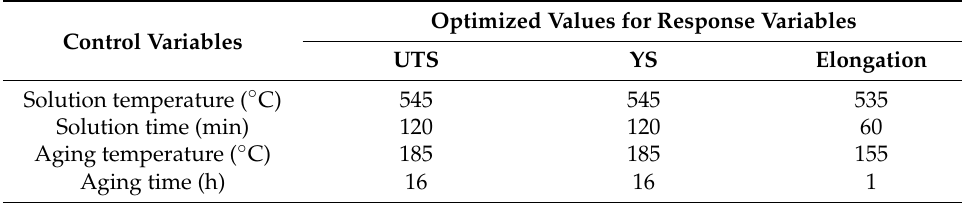
Table 8. Optimized values of control variables for different response